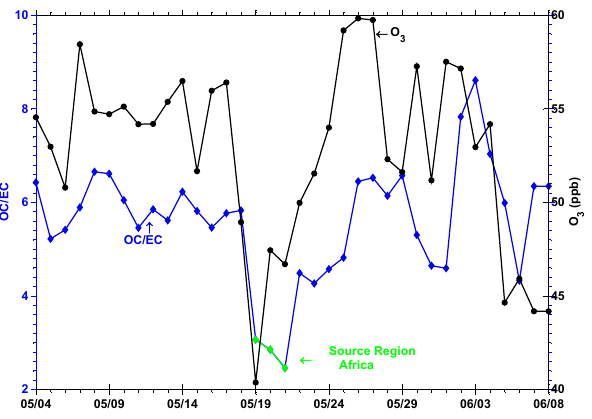
Fig. 11. OC/EC as a function of time. Ozone and OC/EC are mod- erately correlated and have a time lag of one day.